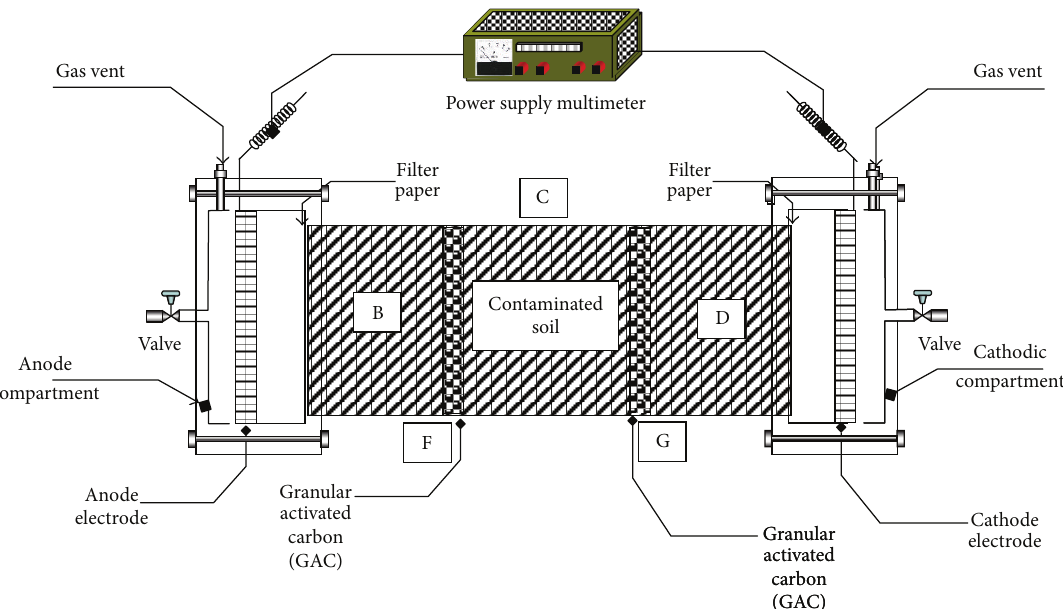
Figure 2: Coupled electrokinetics-adsorption experimental setup.